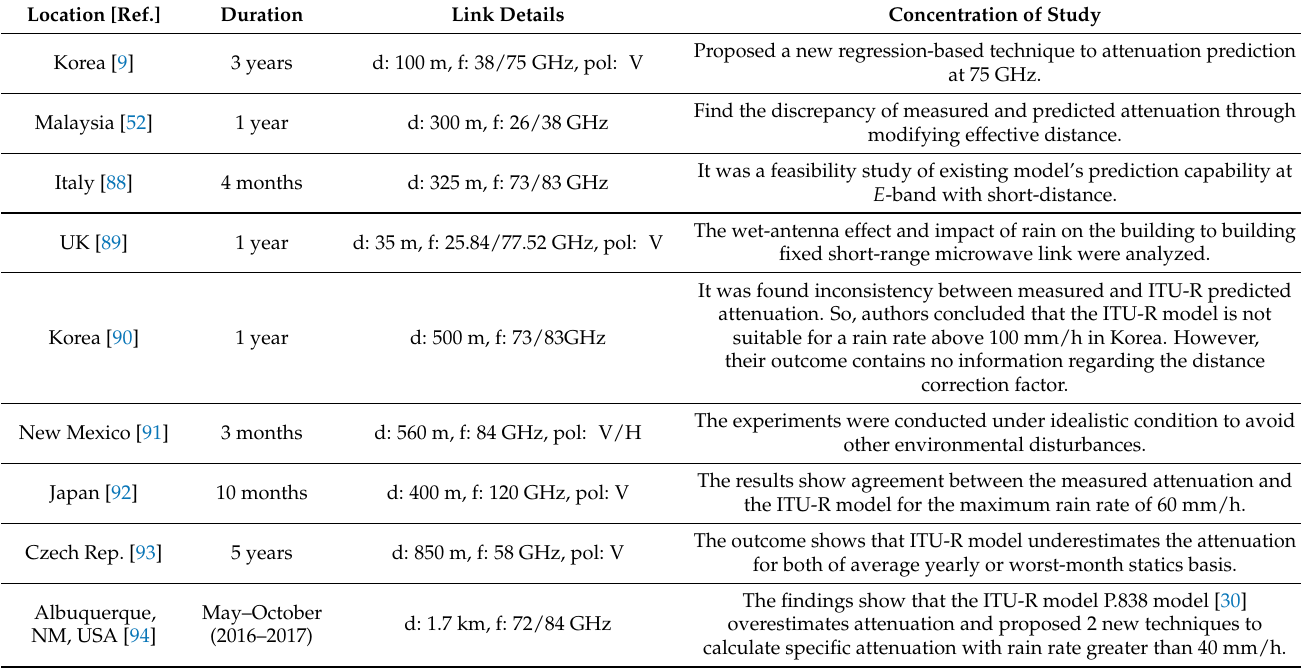
Table 9. ITU-R model is ineffective for short